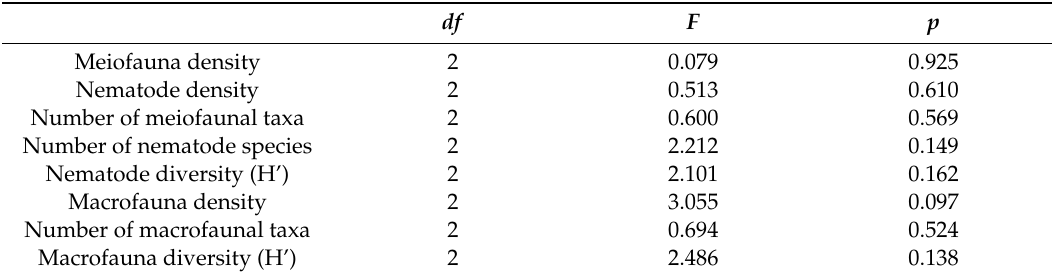
Table 1. Di ff erences in univariate indices from macro- and meiofauna between substrates (H1) using one-way